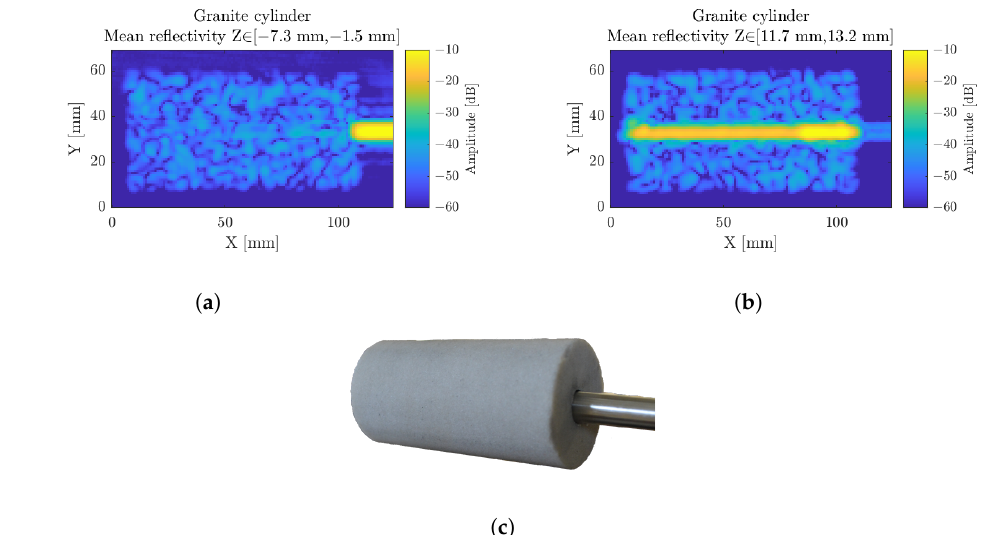
Figure 16. The crushed granite cylinder, considered on a longitudinal range of interest, on the top side ( a ) and on the center ( b ). Photography of the sample ( c